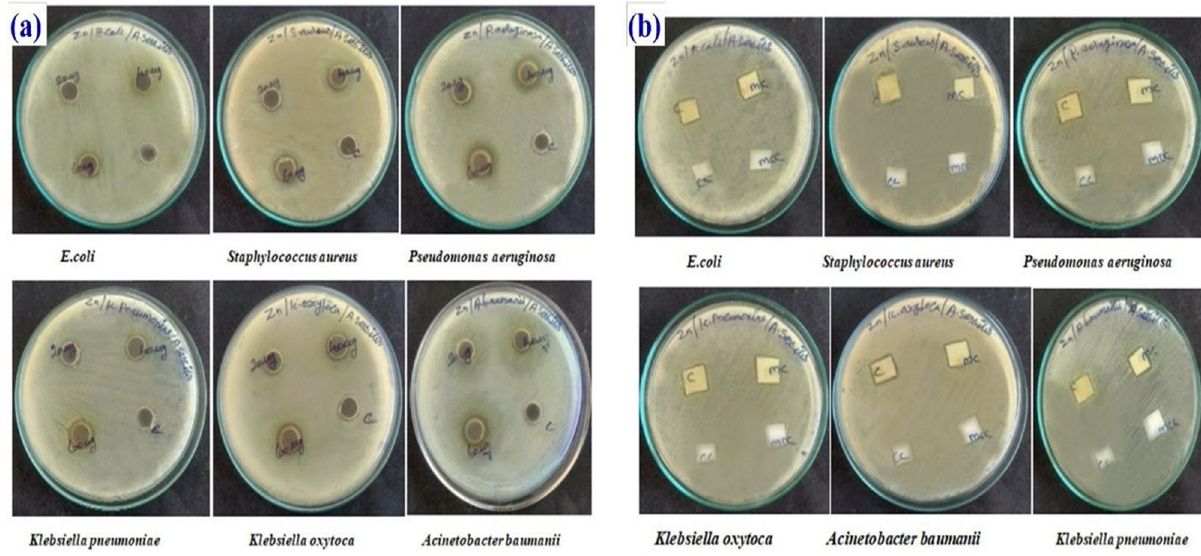
Figure 3: ( a ) Antimicrobial activity of synthesized AS - ZnONPs against the isolates. ( b ) Antimicrobial sensitivity test of AS - ZnONPs coated fabrics against the isolates.